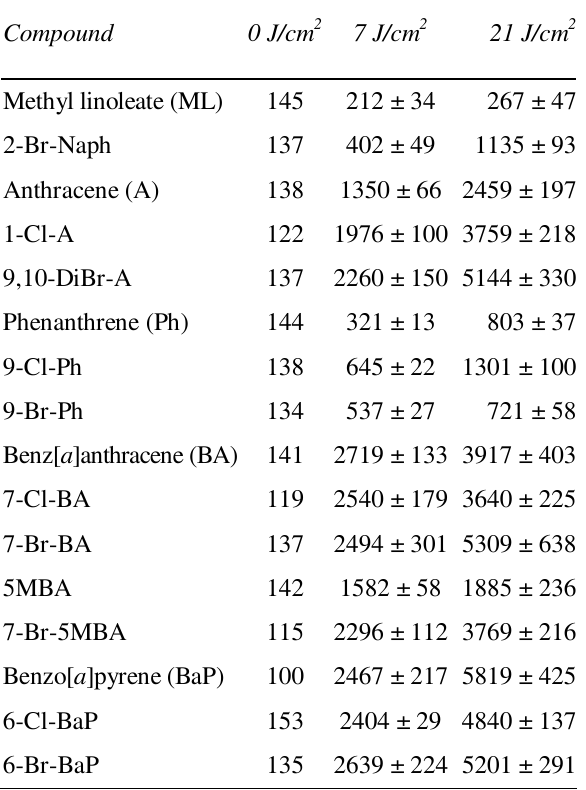
Table 1: Induction lipid peroxidation by halo-PAHs with concomitant exposure to UVA light irradiation a